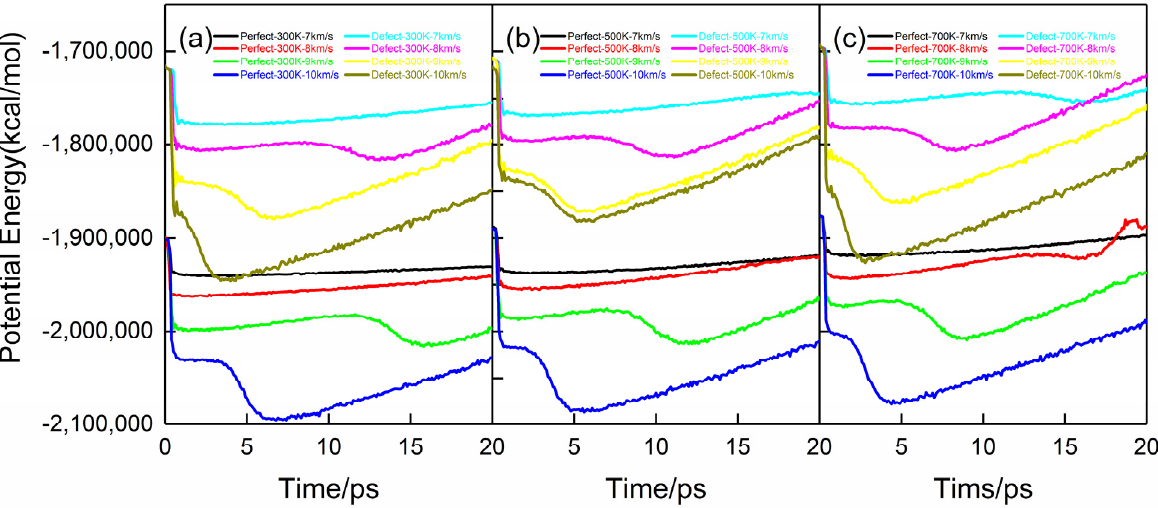
Figure 8. Time − dependent curves of potential energy for the case of U s = 10 km·s − 1 . ( a – c ) correspond Figure 8. Time-dependent curves of potential energy for the case of U s = 10 km · s − 1 . ( a – c ) correspond to PETN crystal with a preheating temperature of 300 K, 500 K, and 700 K. to PETN crystal with a preheating temperature of 300 K, 500 K, and 700